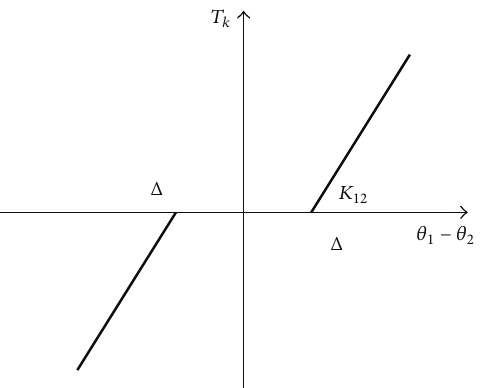
Figure 2: The relationship between torsional torque and rotational angle within